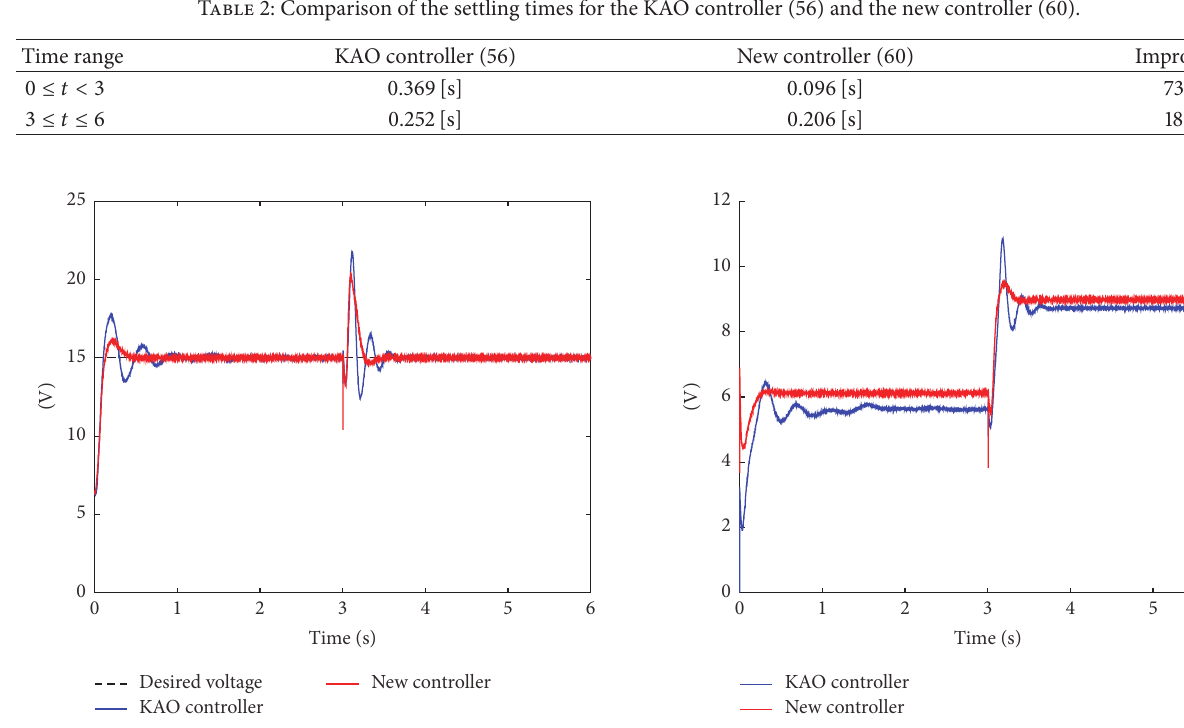
Figure 6: Experimental results: output voltage V 𝑜 (𝑡) obtained with the KAO controller (56) and for the new controller in (60).